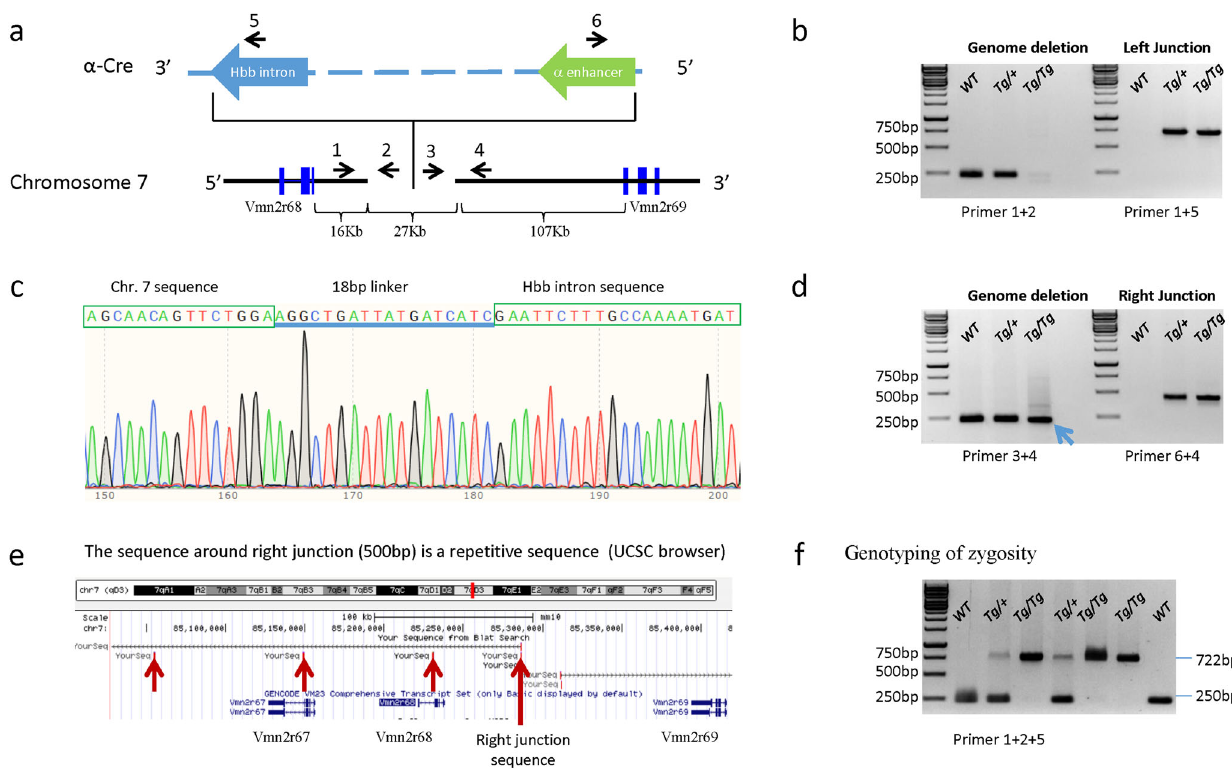
Fig. 2 Con fi rmation of the transgene insertion site on Chromosome 7, and genotyping of zygosity. a Map of the transgene/chromosome 7 left and right junctions. Primers were designed to con fi rm the left and right junctions between the transgene and Chromosome 7, as well as the predicted deletion. b Primers 1 and 2 were used to con fi rm the 27 kb deletion. The 250bp band is absent in putative homozygous α -Cre animals. Primers 1 and 5 were used to con fi rm the left junction between the 3 ′ end of the α -Cre transgene and the 5 ′ end of Chromosome 7 in homozygous animals. This 722 bp band is absent in wild-type animals. c The chromatogram of the 722 bp band in b showing the chromosome 7 sequence linked to the Hbb intron through an 18 bp linker. No intervening SV40 poly A sequence was detected. d Primers 3 and 4 were designed to con fi rm the right-hand junction. However, the 250 bp band is still present in putative homozygous α -Cre animals (arrow). Primers 4 and 6 were used to con fi rm the right junction between the 5 ′ end of the α -Cre transgene and the 3 ′ end of Chromosome 7 in homozygous animals. This 436 bp band is absent in wild-type animals. e The 500 bp chromosome 7 sequence at the right junction of the α -Cre transgene is repetitive (version Mm10). Four such repeats are indicated around Vmn2r67 and Vmn2r68 , (red arrows). f Genotyping zygosity of the α -Cre transgene, using primers 1 + 2 + 5 from the left junction. Totally 7 animals were genotyped, including 2 wild types, 2 hemizygotes, and 3